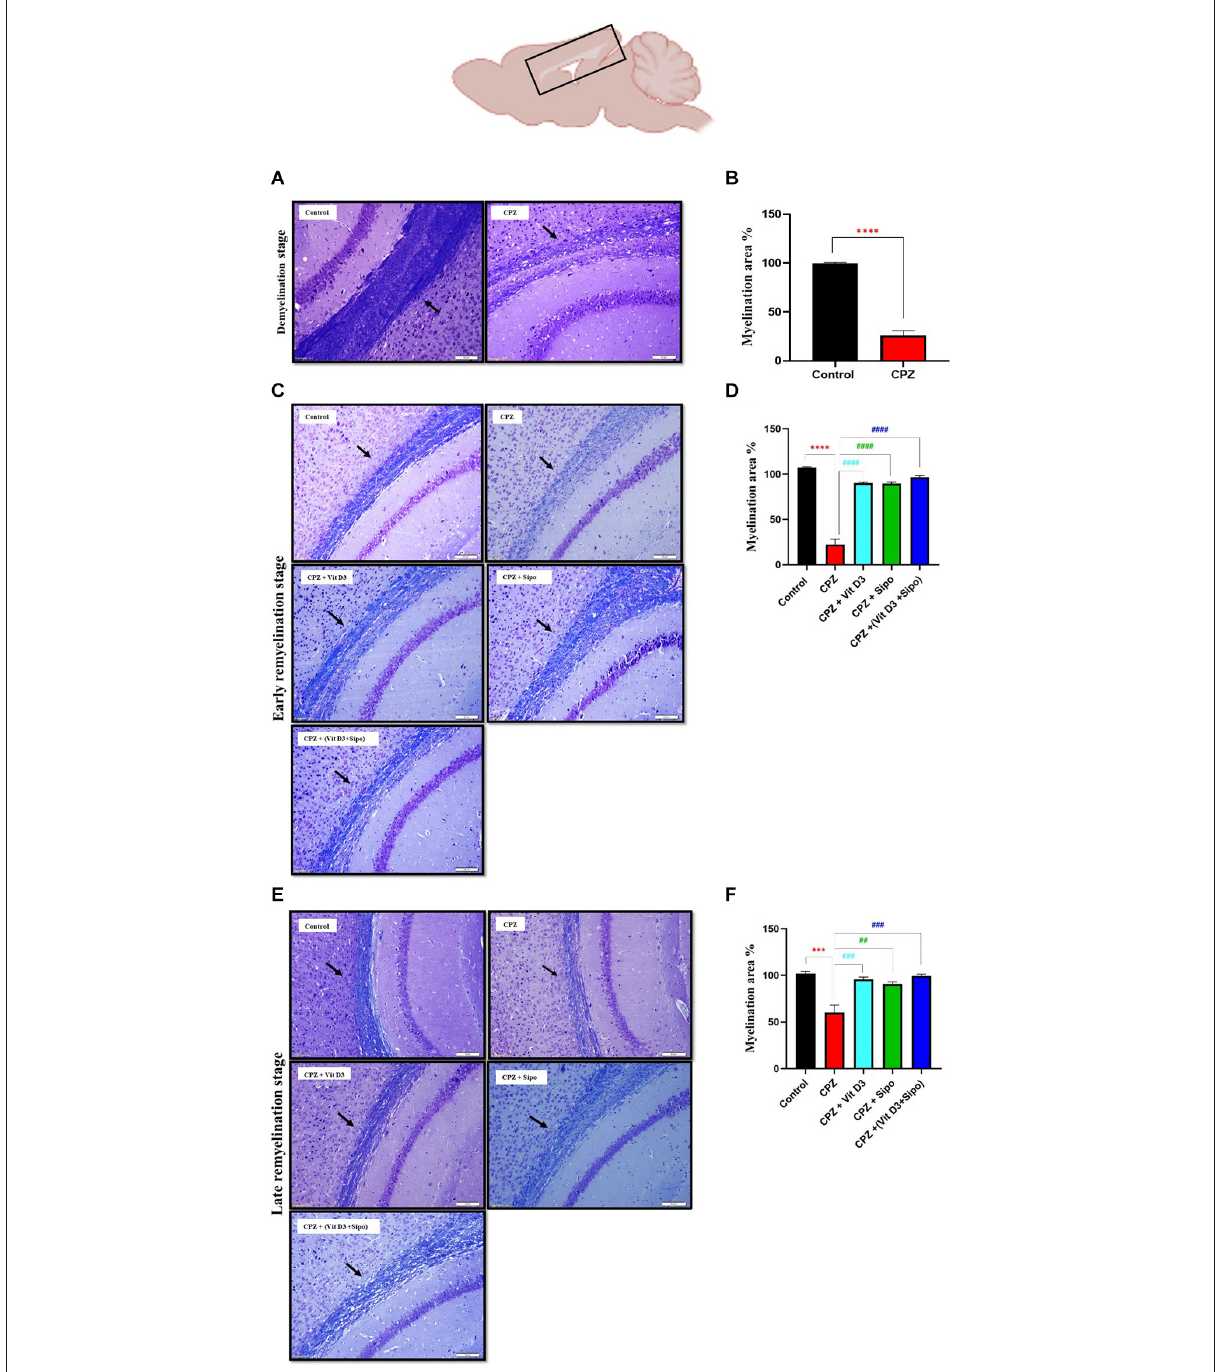
FIGURE6 Evaluation of myelin content in sagittal sections of the CC using LFB staining and quantitative analysis of myelination area during de- and re-myelination stages. (A) Representative image of the CC using LFB staining during the demyelination stage in the control and CPZ group. (B) Percentage of myelination area in CC during the demyelination stage. (C,E) Representative images of LFB CC at the early and late remyelination stage in control and all treated groups, respectively. (D,F) Percentage of myelination area in CC during the early and late remyelination stage, respectively. CPZ administration for 5 weeks caused severe demyelination in the CC compared with the control mice. In contrast, different treatment groups ameliorated myelin injury and enhanced myelination in CC during remyelination stages. Data for Imag j are represented as the mean ± SEM; the t-test was used in (B) , and one-way ANOVA followed by the Tukey’s multiple comparisons test was used in (D,F) . Scale bars: 50 µ m. CPZ, cuprizone; Vit D3, vitamin D3; Sipo, siponimod. ( ∗ ) Indicates a significant difference vs. the control group; ( # ) indicates a